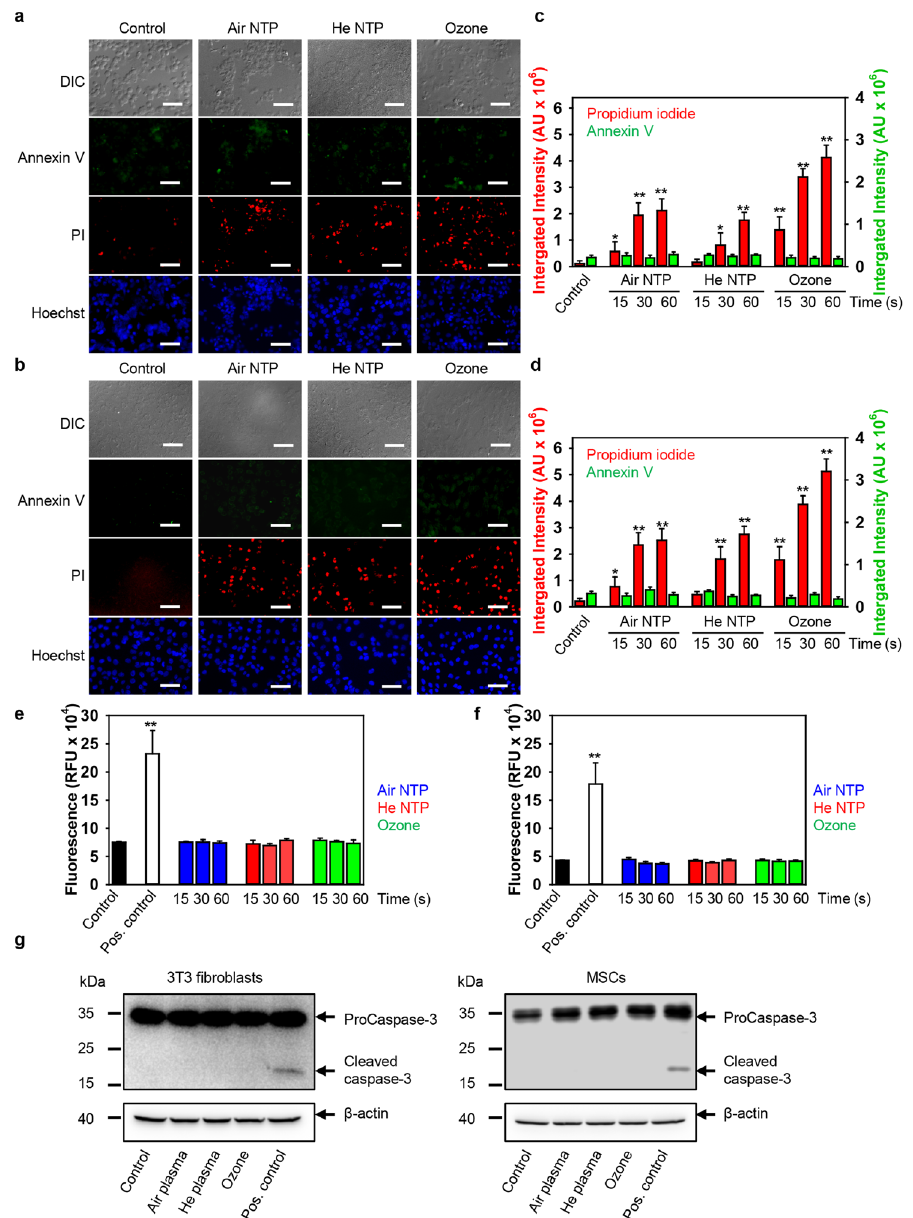
Figure 2. Analysis of apoptosis hallmarks after plasma treatment. 3T3 fibroblasts ( a ) or MSCs ( b ) were treated with air, helium NTPs or ozone for 60 s, then 4 h after treatment cells were labeled with Hoechst nuclear stain – blue dye, annexin V – green dye and propidium iodide – red dye. Labelled cells were imaged with fluorescence microscopy. Representative images out of three independent experiments are shown. Scale bar 100 µ m. ( c ) Annexin V and PI image quantification of plasma-treated 3T3 fibroblasts. Annexin V – green dye and propidium iodide – red dye fluorescence intensities were analyzed with ImageJ. The data present mean values of three independent experiments. In each experiment 5 randomly selected fields for each sample were quantified. Data are expressed as means ± SEM (n = 3), * P < 0.05 ** P < 0.01. ( d ) Annexin V and PI image quantification of plasma-treated MSCs. Annexin V – green dye and propidium iodide – red dye fluorescence intensities were analyzed with ImageJ. The data present the mean values of three independent experiments. In each experiment 5 randomly selected fields for each sample were quantified. Data are expressed as means ± SEM (n = 3), * P < 0.05 ** P < 0.01. Caspase-3 activation assay in 3T3 fibroblasts ( e ) and MSCs ( f ). Cells were stimulated with air, helium NTPs and ozone for the indicated period of time. Further, 4 h post-treatment cells were incubated with caspase-3 inhibitor VAD-FMK conjugated to FITC (FITC-VAD-FMK). Following staining, cells were analyzed using a fluorescent microplate reader (Tecan Infinite ® 200 PRO). Readings were done in quadruplicates. As a positive control, cells were treated with 2 μ M staurosporine for 3 h. The data present the mean values of four independent experiments. Data are expressed as means ± SEM (n = 4). ( g ) Air, helium NTPs and ozone do not induce caspase-3 activation. 3T3 fibroblasts and MSCs were stimulated with air, helium NTPs and ozone for 30 s. Cells were analyzed by Western immunoblotting 4 h post-treatment. Actin – control of equal protein loading. Representative blots out of three independent experiments are shown. As a positive control, cells were treated with 2 μ M staurosporine for 3